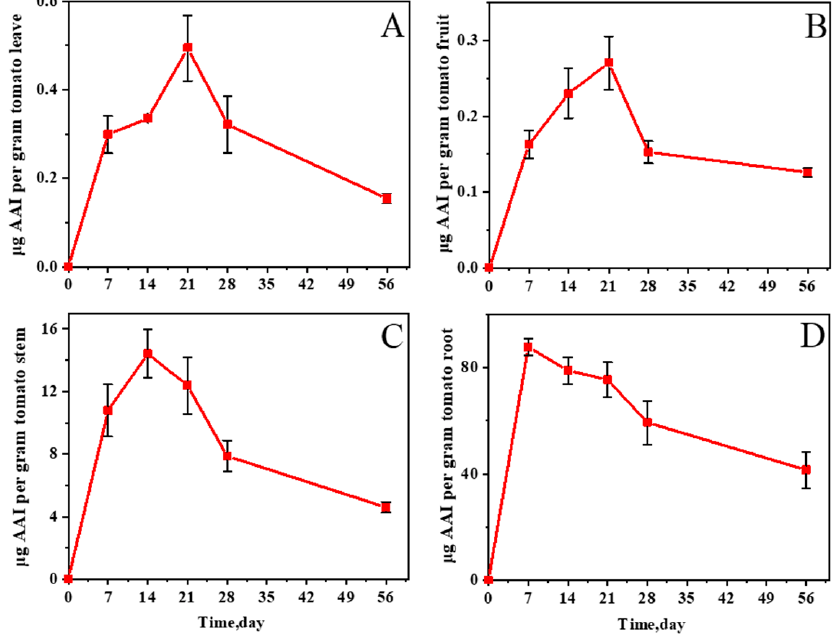
Figure 5. Changes in AA I concentration in tomato leaves ( A ), fruits ( B ), stems ( C ), and roots ( D ) grown in AA-contaminated soil.